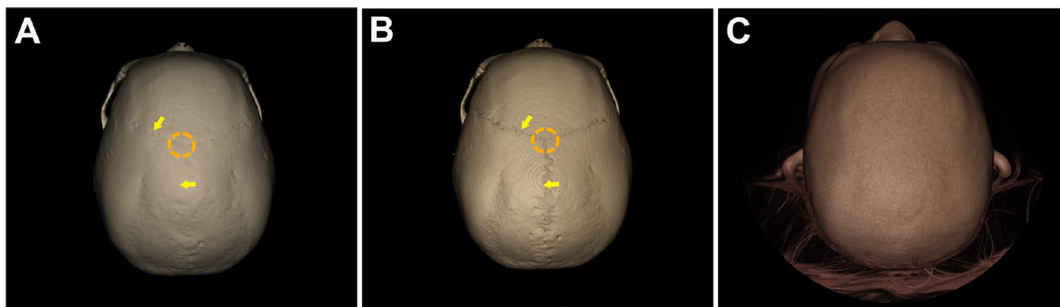
Figure 2. Different modeling images for the same cranial vault seen from the top view of the same subject. ( A ) 3D mesh-model in stereolithographic format with faint coronal suture and bregma, but invisible sagittal suture; ( B ) another top view of the same cranial vault by volume-rendered modeling in bone setting, showing these structures more clearly; ( C ) the same top view of skull, produced by volume rendering in a soft tissue setting, showing the nose, ear, and other skin